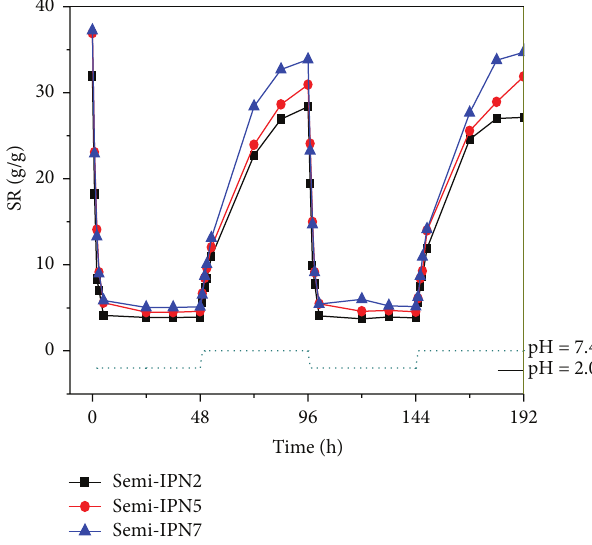
Figure 6: Swelling reversibility of the xylan/PMAA semi-IPN hydrogels in pH 2.0 and pH 7.4 buffer